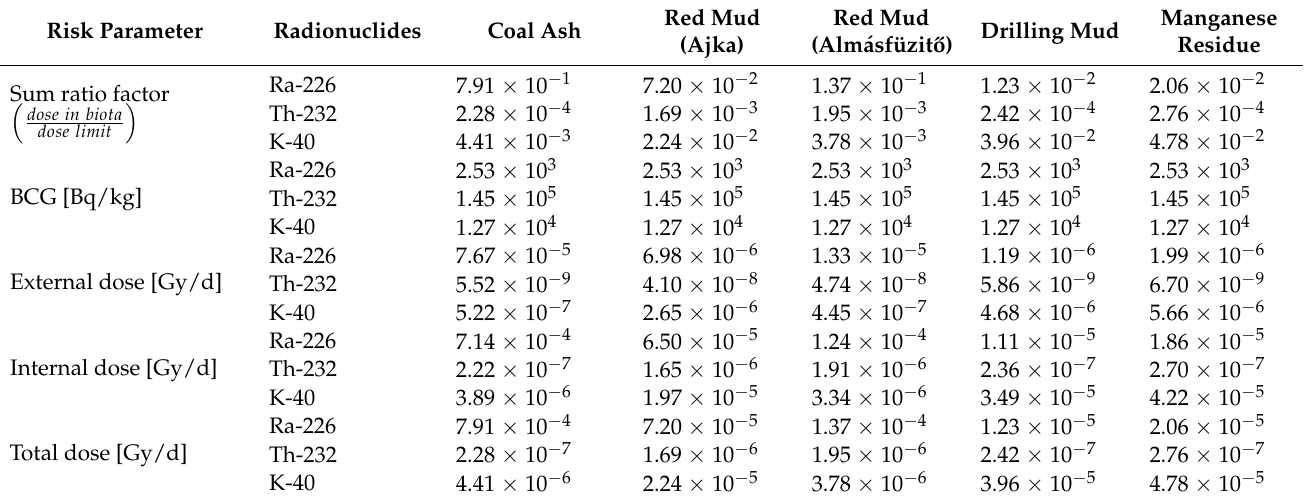
Table 5. Risk parameter in terms of radionuclides and materials (150 kg).